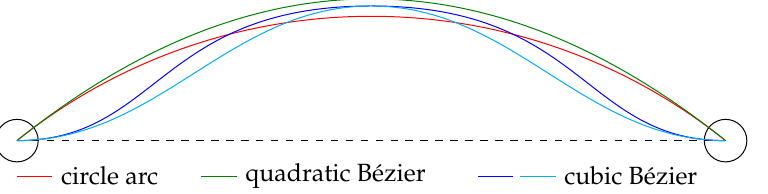
Figure 2. Examples of several possible simple shapes for an arm link (blue and cyan show cubic Bézier curves with different pointedness near the middle